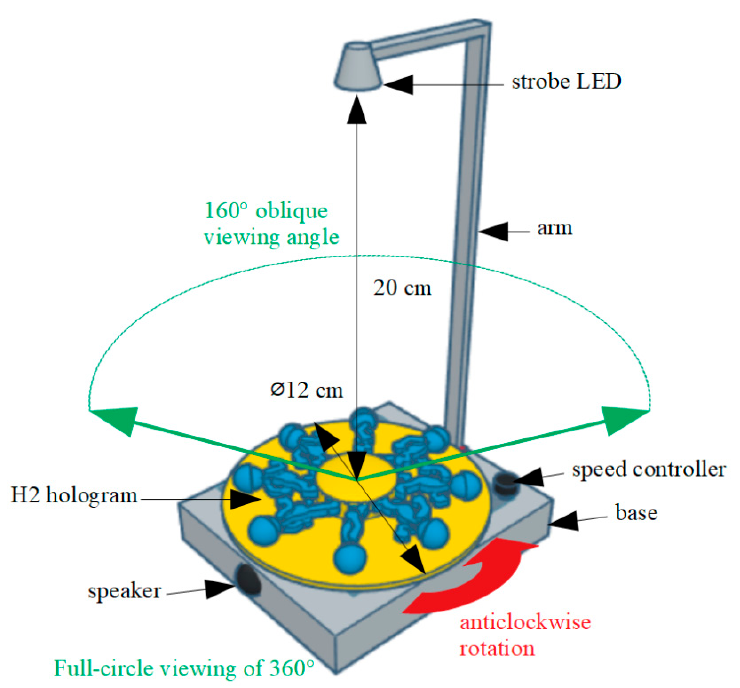
Figure 5. Schematic diagram for the proposed Zerotrope structure.